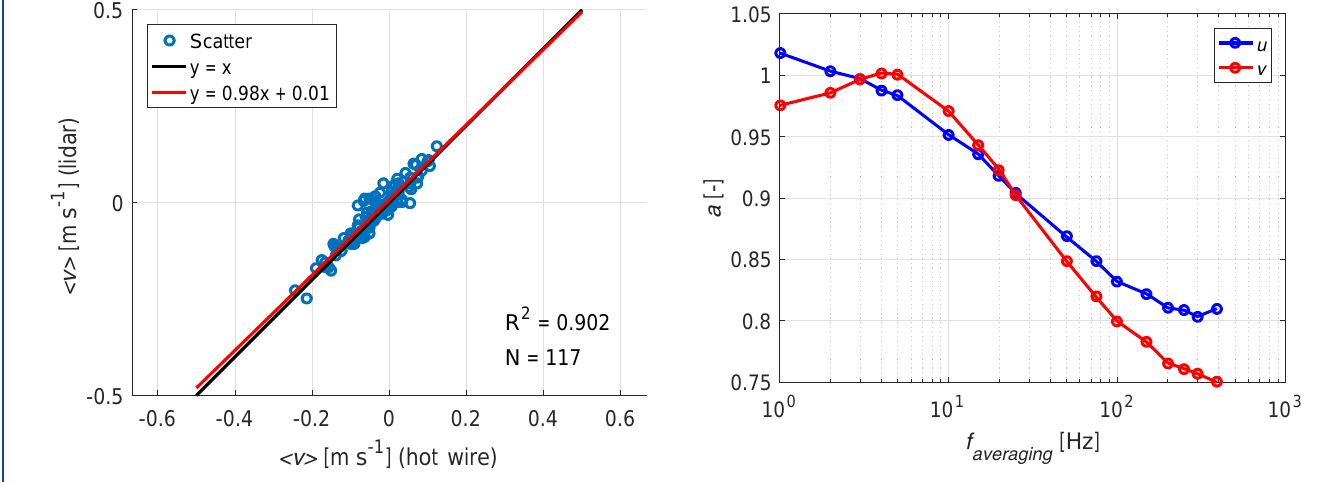
Figure 19. Slope a of the linear fit between the averaged u and v components of the lidar and the hot wire as a function of the aver- aging